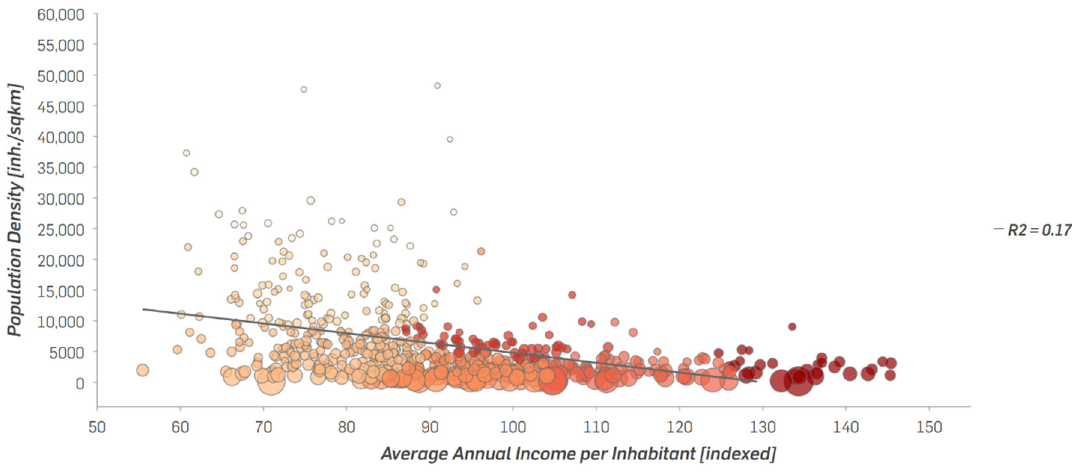
Figure 8. Regression analysis for average annual income per inhabitant and population density in PLZ8 polygons, dot size in scatterplot proportional to relative polygon area (Source: authors).